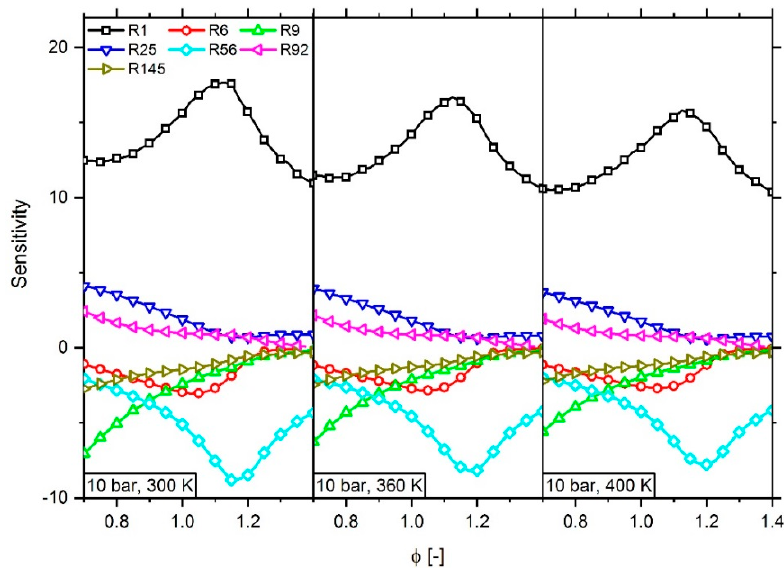
Figure 19. Analysis of the most sensitive reactions regarding the laminar flame speed as function of the fuel – air equivalence ratio φ using a methane – air mixture at 300 ( left ), 360 ( middle ), and 400 K ( right ) and 10 bar.